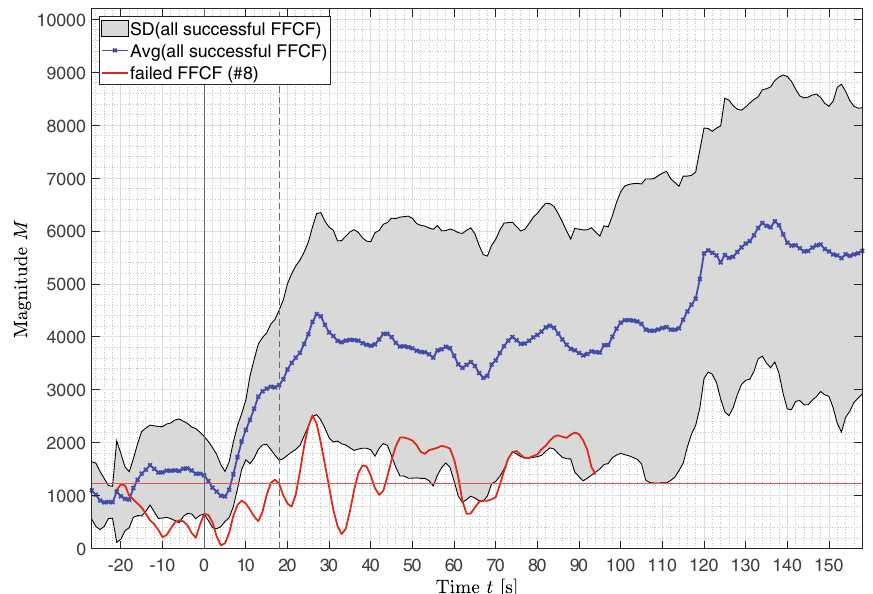
Figure 8. Magnitude M. The blue curve represents the average of all successful transplanted FFCFs and the gray area includes the SD. In comparison, the red curve shows the correlation of failed flap (#8). The time point t = 0 s marks the documented reperfusion. The reperfusion is detectable in the data after t = 18.08 s. The horizontal red line marks the average magnitude of the failed flap with M = 1234.1 ± 639.7 , which corresponds to the average magnitude of the ischemic FFCF M ischemia = 1246.6 ± 224.7